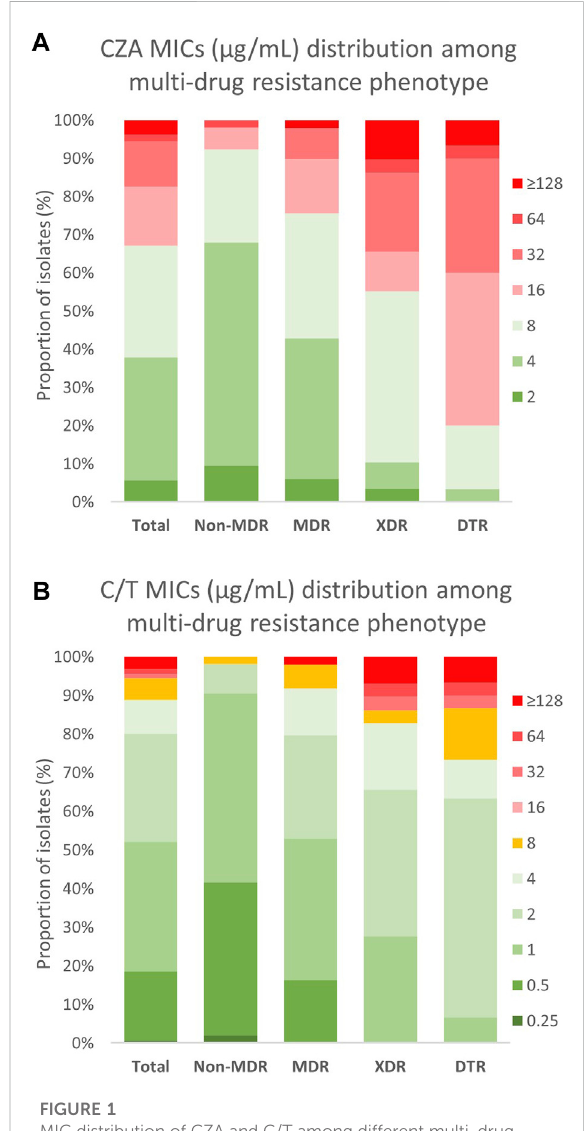
FIGURE 1 MIC distribution of CZA and C/T among different multi-drug resistance phenotypes in Non-CP-CRPA clinical isolates. Non- CP-CRPA isolates (Total) were classi fi ed as Non-MDR, MDR, XDR, and DTR. The distribution of (A) CZA and (B) C/T MIC values among these groups are represented in thegraphic. Green, yellow and red colors indicate MIC values considered by CLSI as “ susceptible ” , “ intermediate ” , and “ resistant ” , respectively. It is observed that acquisition of each more multi-drug resistance phenotype is strongly associated with the increase of (A) CZA and (B) C/T MIC values, in particular for